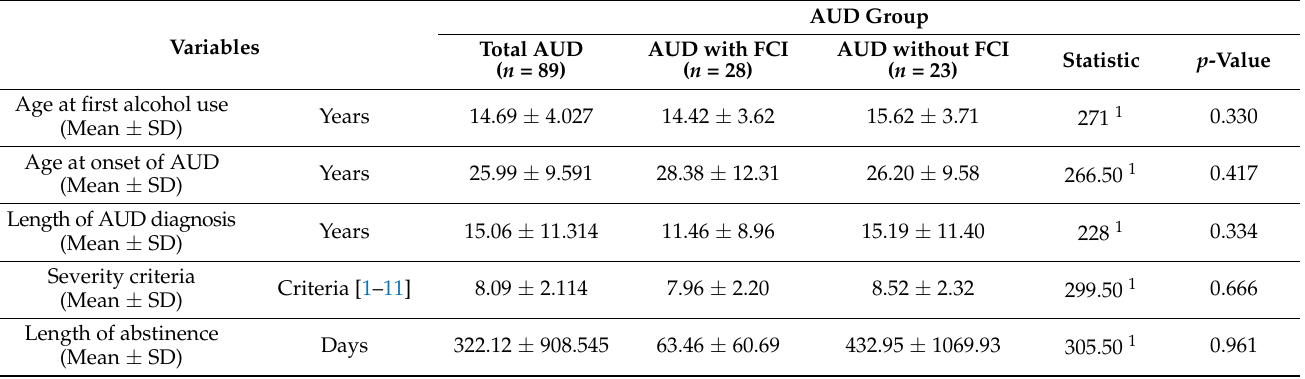
Table 2. Clinical characteristics of AUD patients with and without frontal cognitive